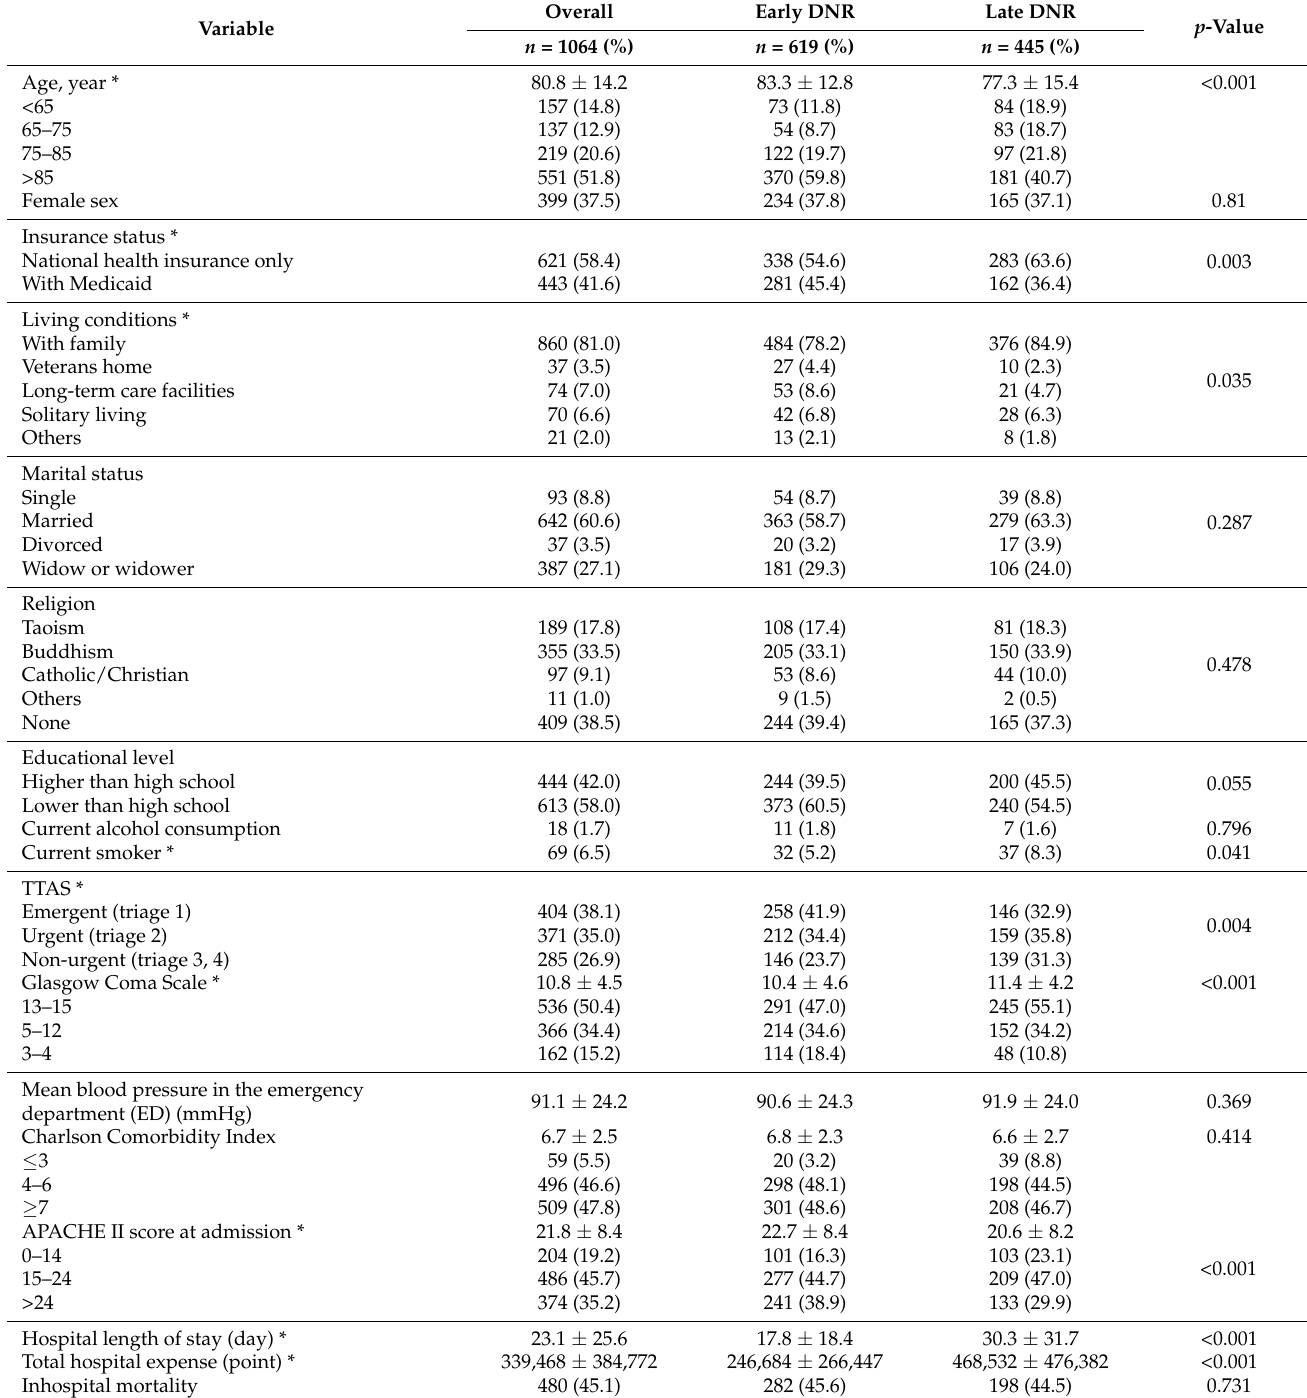
Table 2. Comparison of clinical characteristics between early DNR and late DNR